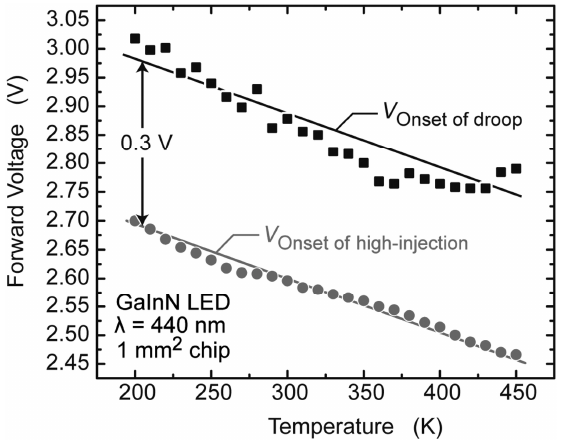
Figure 1. Voltage at the onset of high injection and voltage at the onset of the efficiency droop (i.e., the peak-efficiency point) as a function of temperature. This figure is reprinted from Ref. [51], with the permission of AIP Publishing LLC.